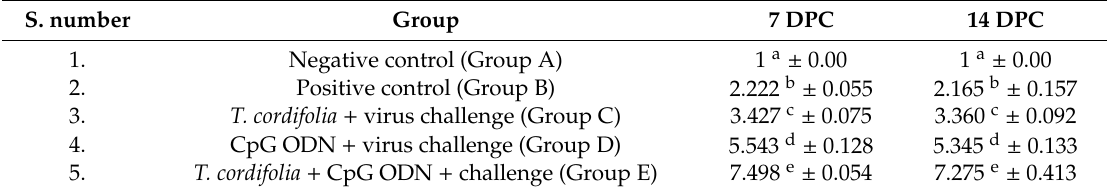
Table 10. Quantitative real time PCR analysis of IL-1 β expression in the bursa of Fabricius of chickens challenged with vvIBDV at di ff erent DPC.